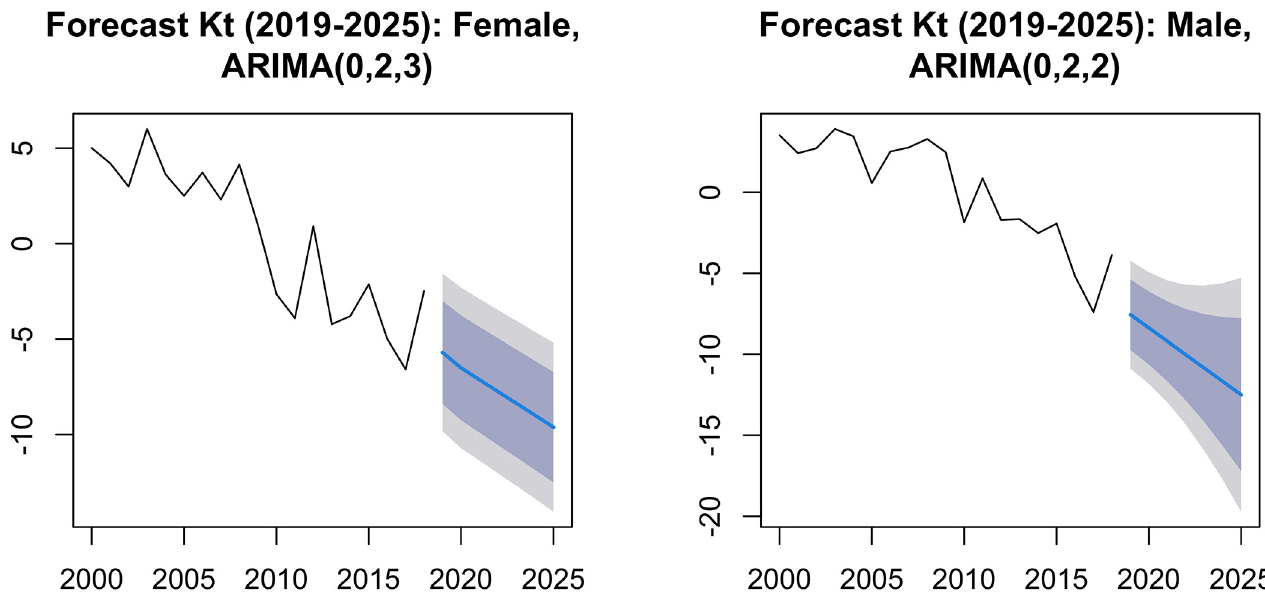
Fig 16. Forecast of kt, (2019–2025) by the ARIMA model (0,2,3) for females and ARIMA (0,2,2) for males.